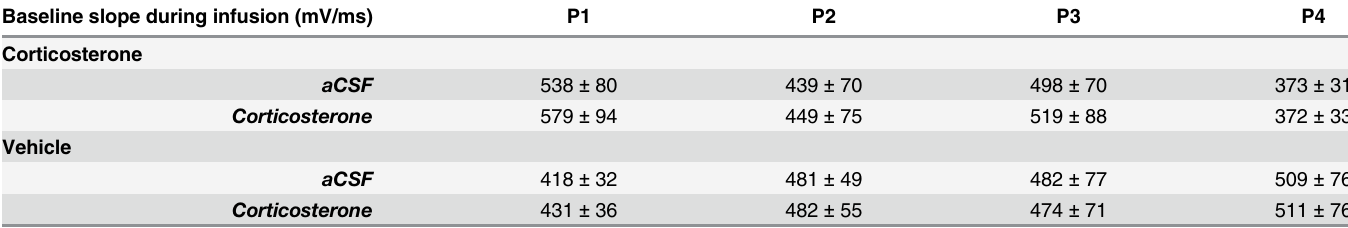
Table 4. Averaged values of the baseline CA1 fEPSP slope (mV/ms) of hippocampal brain sections of young adult mice that have been exposed to either four corticosterone or vehicle pulses (P1-4). For each pulse the average baseline is indicated before (aCSF) and during corticosterone exposure. The values are expressed as mean ± SEM for each experimental group (based on 6 – 9 recordings per group). Baseline slope during infusion